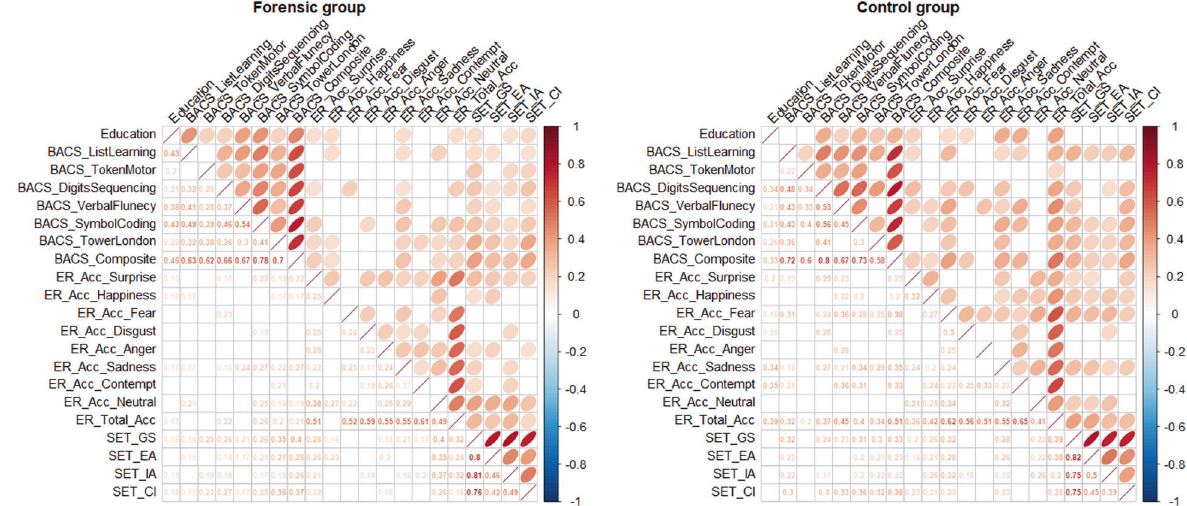
Fig. 1 Correlation plots. Correlations among education, BACS, ER and set scores in the forensic (left panel) and in the control (right panel)